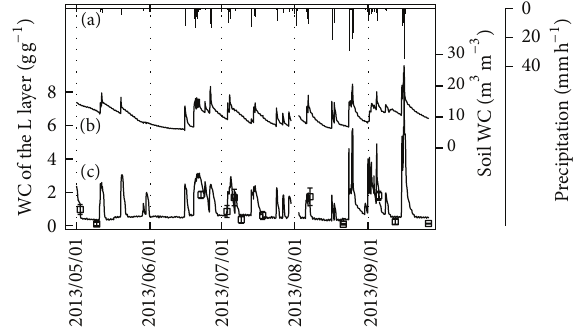
Figure 4: Temporal variation in (a) hourly precipitation, (b) volumetric soil water content at a depth of 0–5 cm in mineral soil depth, and (c) water content obtained using the LWC method ) and the gravimetric water content (WC (WC LWC 5 method Square) in the L layer in a temperate broad-leaved secondary forest at Yamashiro Experimental Forest (YMS) from May to September 2013. Error bars are standard